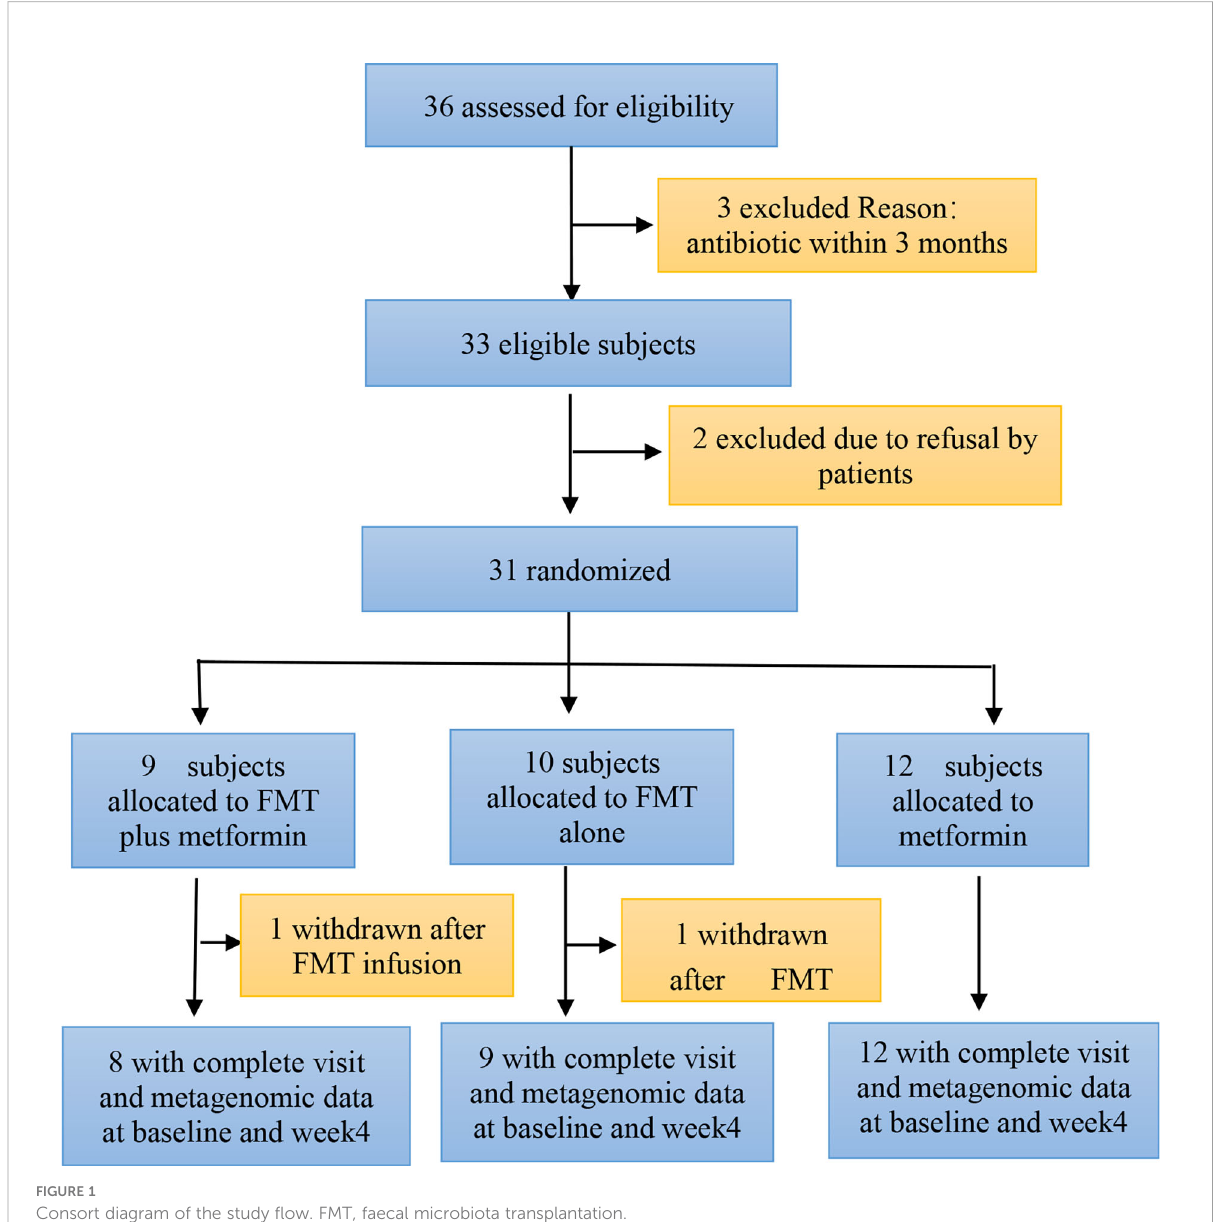
FIGURE 1 Consort diagram of the study fl ow. FMT, faecal microbiota